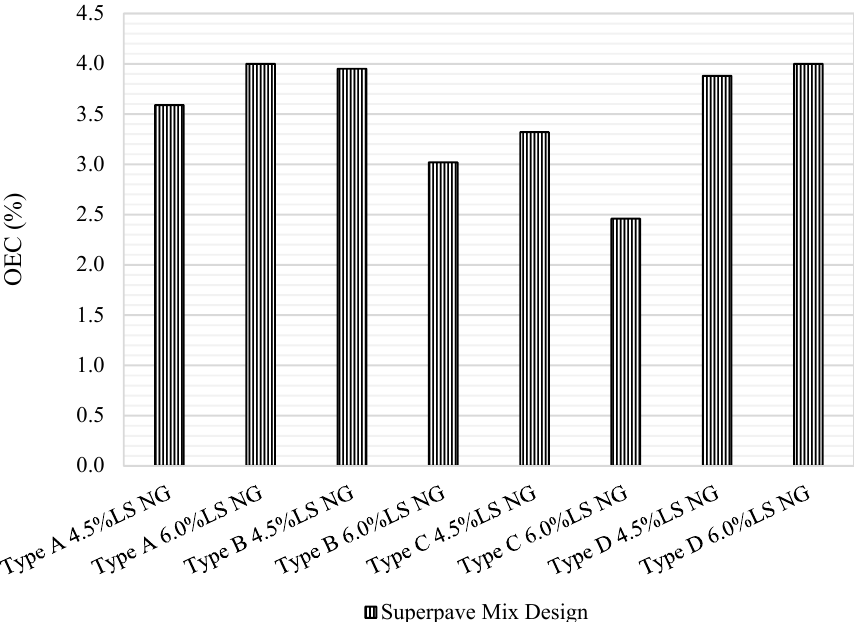
Figure 1. Optimum emulsion content based on Superpave mix design.